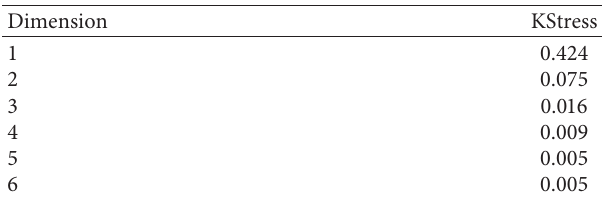
Table 3: Dimension and Kruskal stress index.